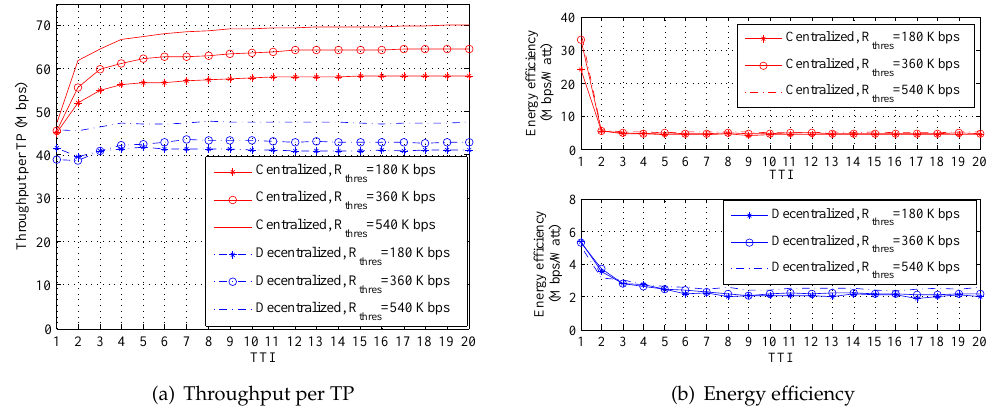
Figure 8. System performance under different R thres (20 Watts, C m = 100 Mbps